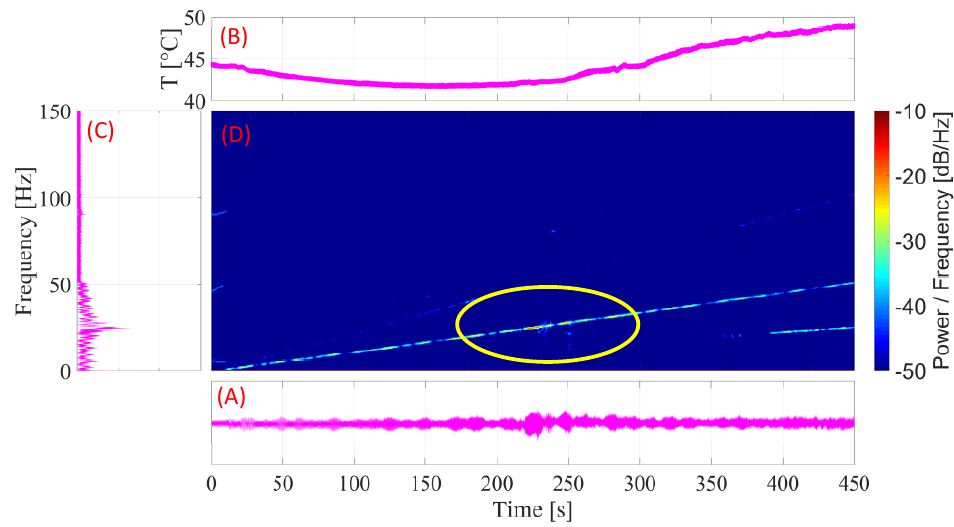
Figure 15. Curves for the SMA-SE M-Shape device with a pre-load of 1.0 mm: ( A ) amplitude × time; ( B ) temperature × time; ( C ) FFT; ( D ) spectrogram.